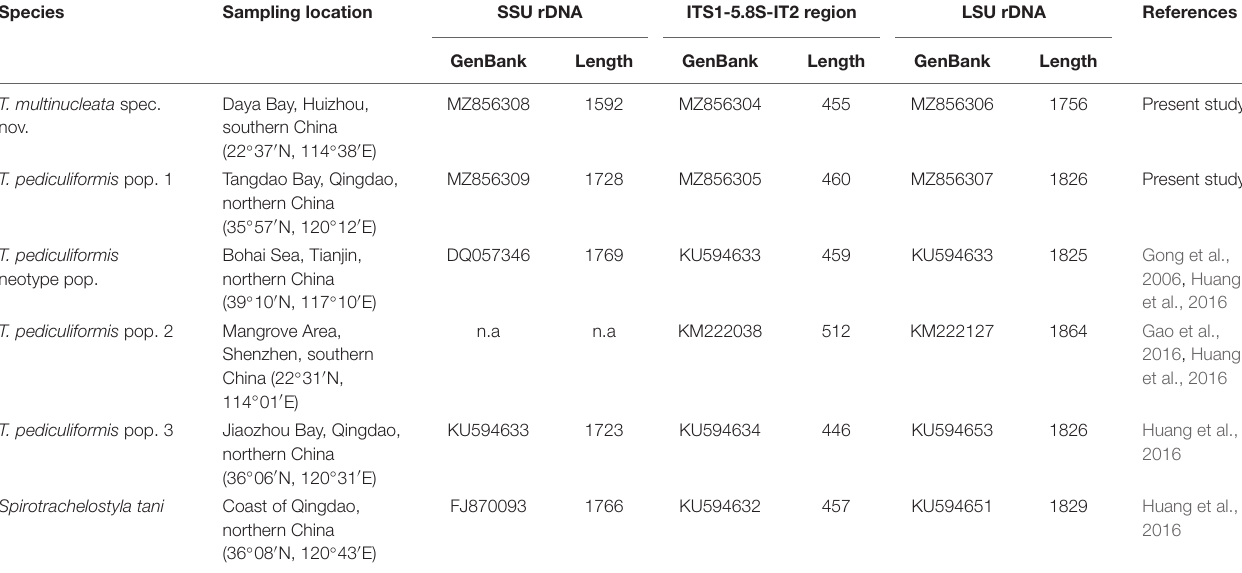
TABLE 2 | Origin, characterization, and GenBank accession numbers of trachelostylid species collected from Chinese